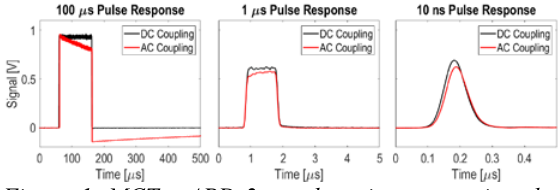
Figure 1. MCT e-APD 2- µ m detection system impulse response using dc and ac coupling at different radiation pulse-width. Results obtained using gain setting of 0, 77.6K and 12 V bias.